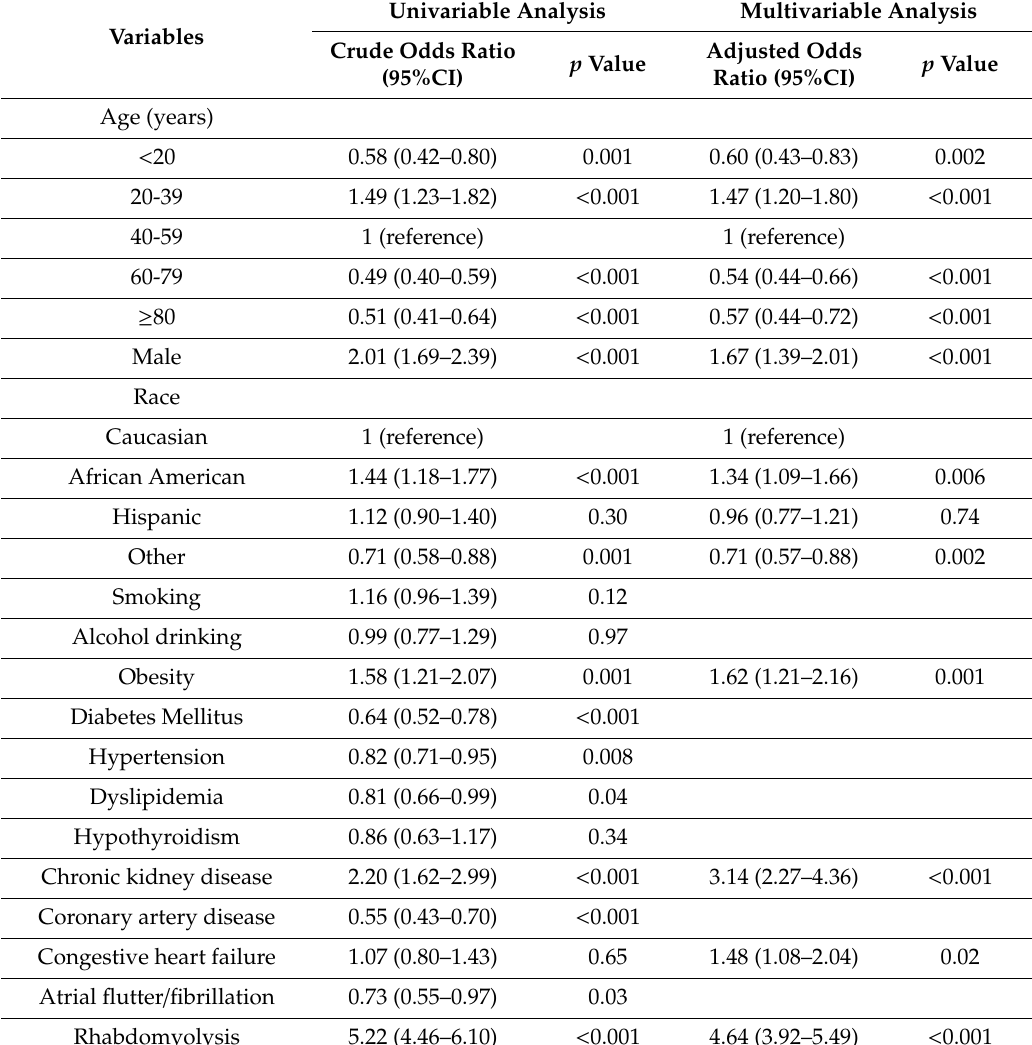
Table 2. Factors associated with acute kidney injury in heat stroke